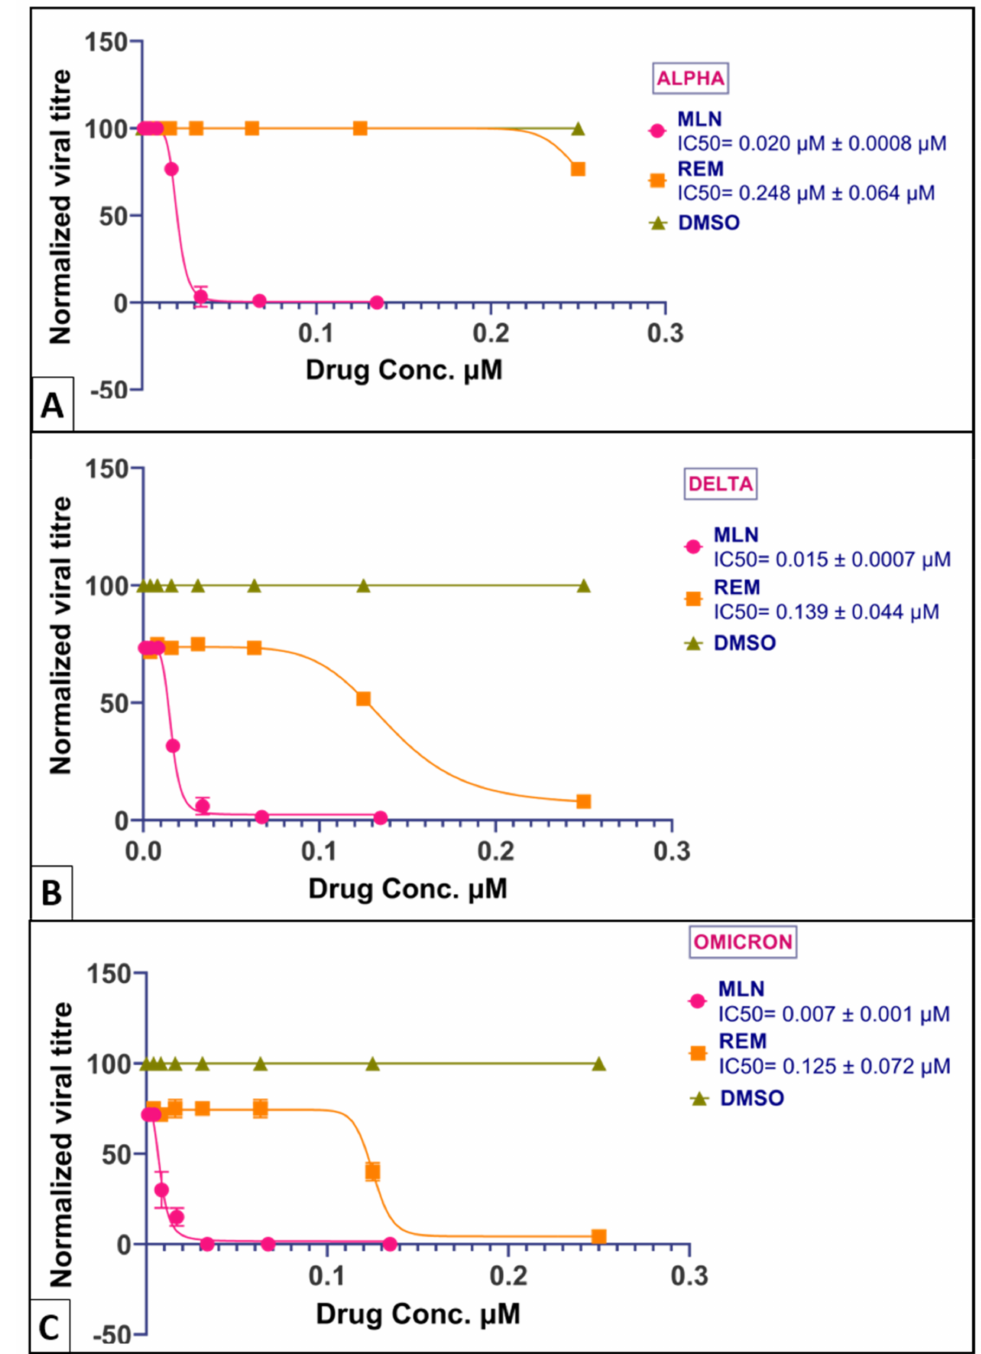
Figure 5. Shows the inhibition curve of MLN (hexagon data points) vs. Remdesivir (Triangular data points) against different lineages (VOCs) of SARS-CoV-2. ( A ) Alpha strain, ( B ) Delta strain, and ( C ) Omicron strain. MLN has consistent efficacy against all three